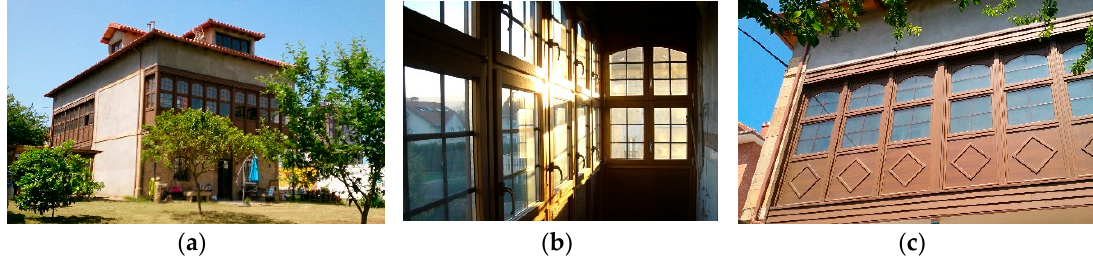
Figure 1. ( a ) External view to the TAH from the south . ( b ) Inside detail of south-east balcony. ( c ) Outside detail of south-west balcony.